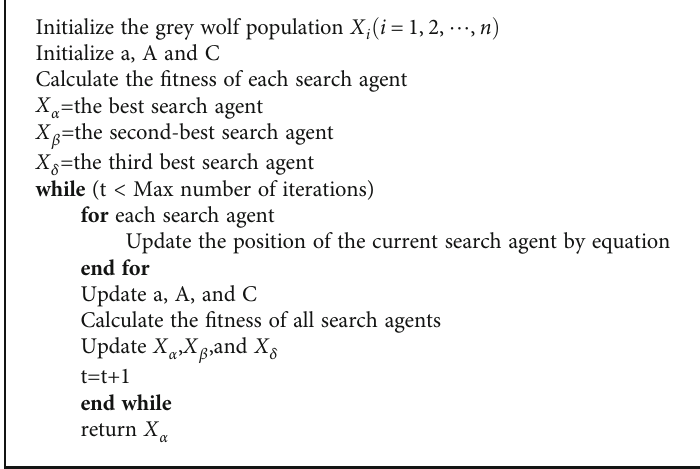
Pseudocode 1: Pseudocode of the grey wolf